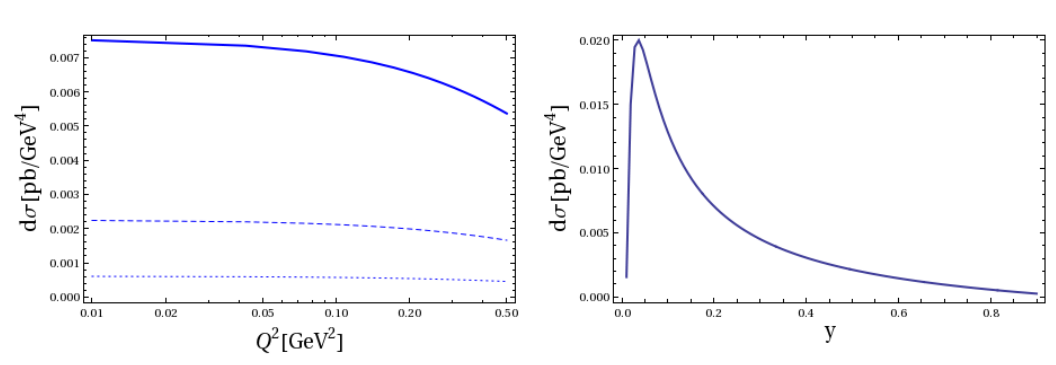
) d σ ( e − N → ν ND − s (in pb d y dQ 2 dt = 0 and s = 820 GeV 2 T